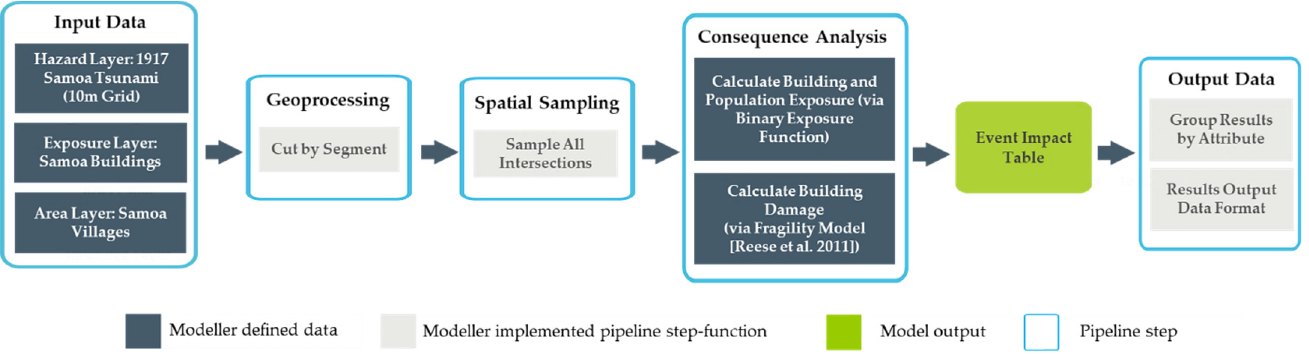
Figure 3. A schematic representation of the RiskScape model pipeline steps and functions applied in this study. this